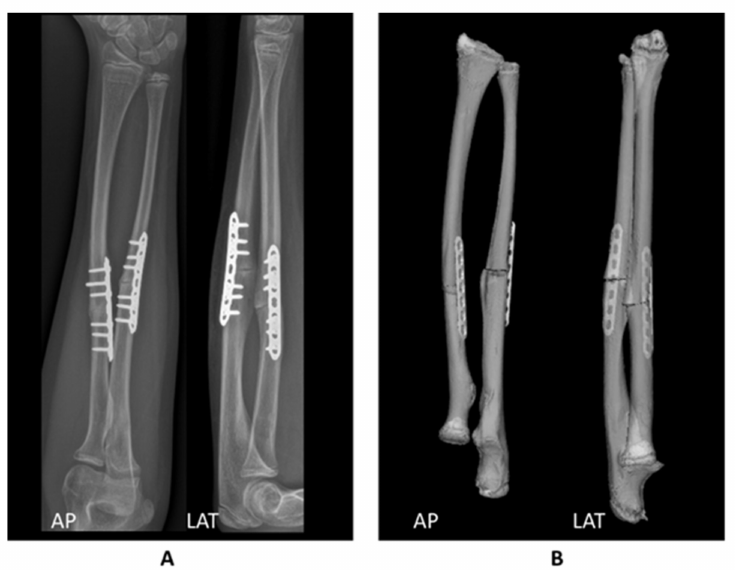
Figure 4. Comparison between ( A ) the postoperative radiographs and ( B ) the 3D planned postopera- tive position. Based on visual comparison, the correction was performed as